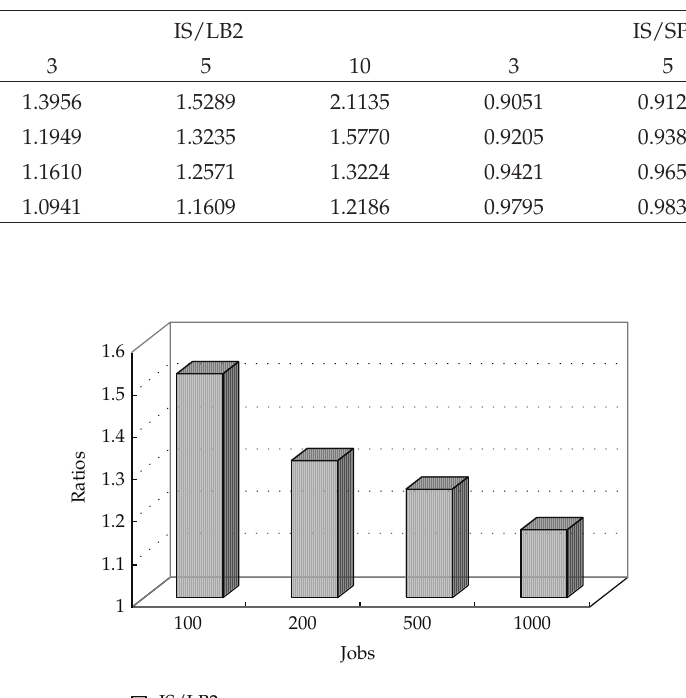
Table 1: The experiment results.